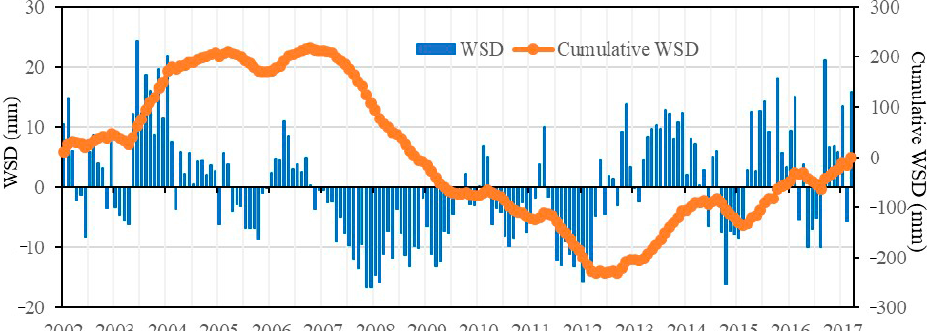
Figure 5. Time series of water storage deficit (WSD) and cumulative WSD for Mongolia from 2002 to 2017.